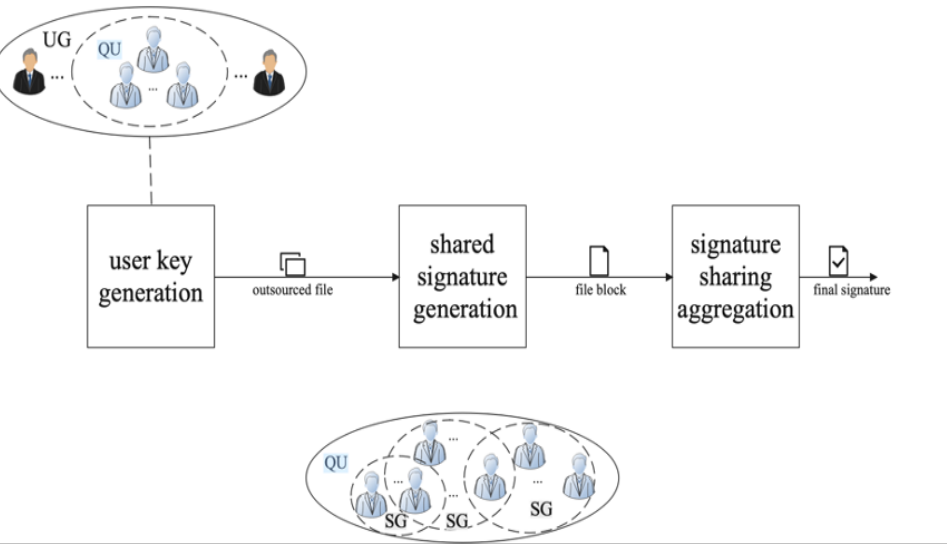
Figure 2. Signature generation